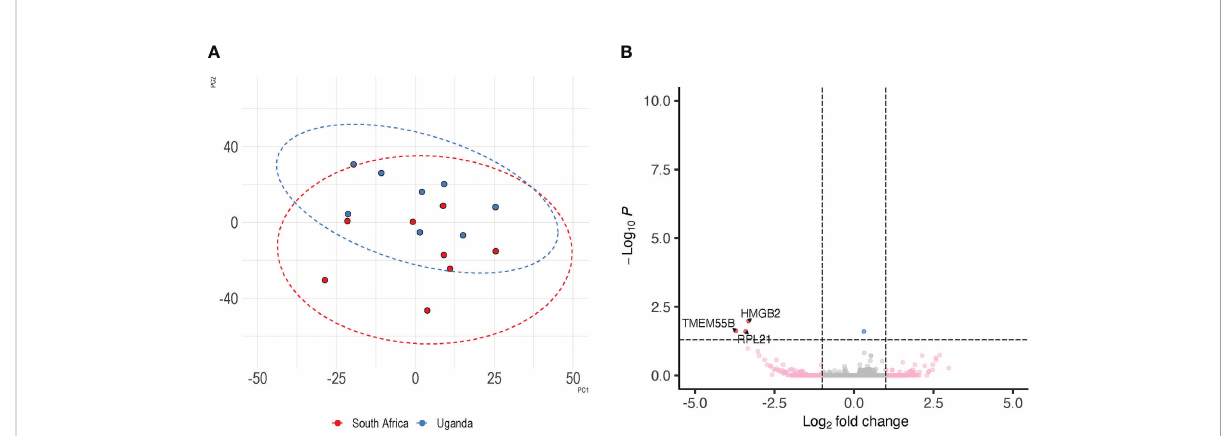
FIGURE 3 Similarity of control specimens in Uganda and South Africa. To evaluate the extent of inter-country variability we performed a differential expression analysis between the control arms of South Africa and Uganda. Panel (A) depicts the distribution of control specimens produced by PCA; the overlap between the two countries is shown by corresponding ellipse. Panel (B) shows the detection of 3 DEGs between the controls from the two trial sites.